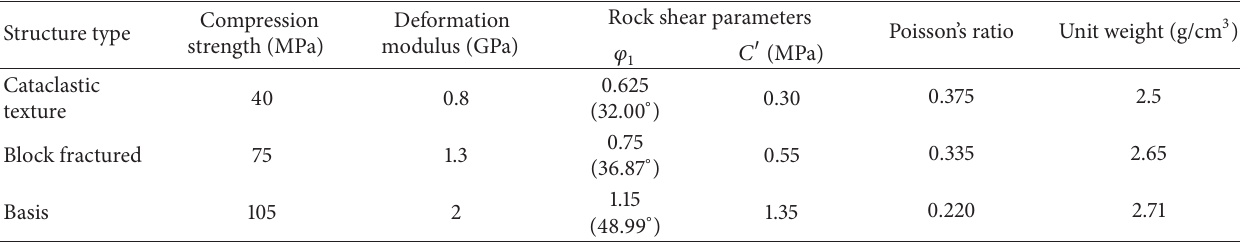
Table 4: Rock material parameters of the DP3 criterion.